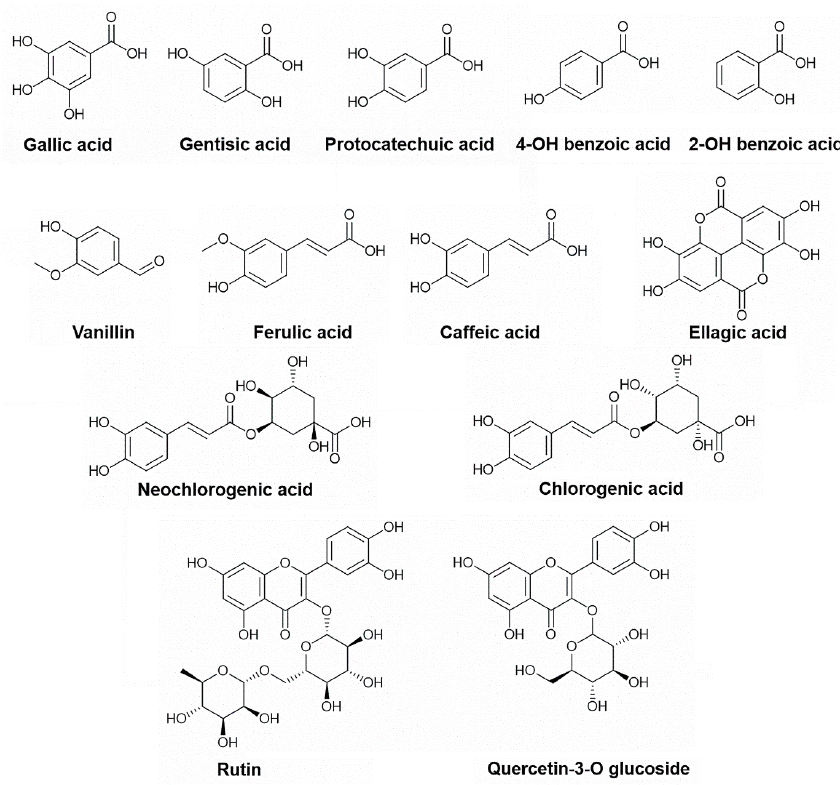
Fig. 2: Phenolic acids and flavonoid glycosides that are identified and quantified in this study.